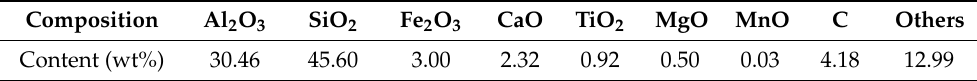
Table 1. Chemical composition of fly ash